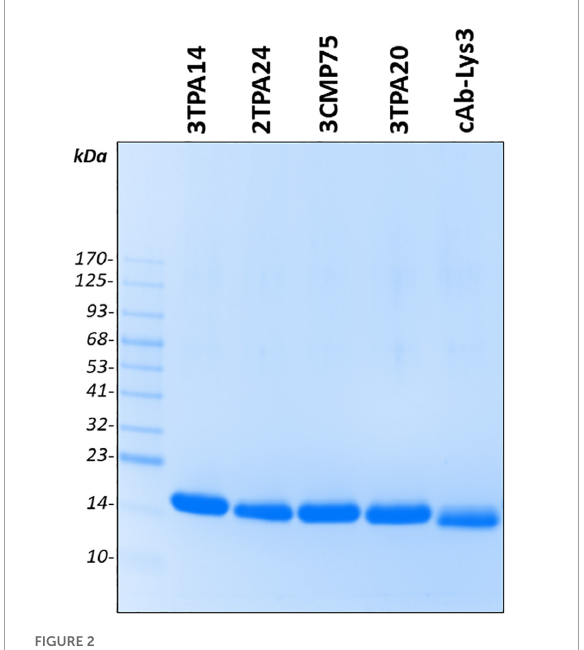
FIGURE2 Purification of the selected anti- membrane type 1-matrix metalloproteinase (MT1-MMP) nanobodies. Sodium dodecyl sulfate-polyacrylamide gel electrophoresis (SDS-PAGE) analysis followed by Coomassie Blue staining in a 4–20% gradient polyacrylamide gel of purified nanobody clones 3TPA14, 2TPA24, 3CMP75, 3TPA20, and cAb-Lys3 as non-specific one. Periplasmic extract were subject to immobilized metal ion affinity chromatography followed by size exclusion chromatography in PBS buffer. Molecular weight markers are indicated at the left of the